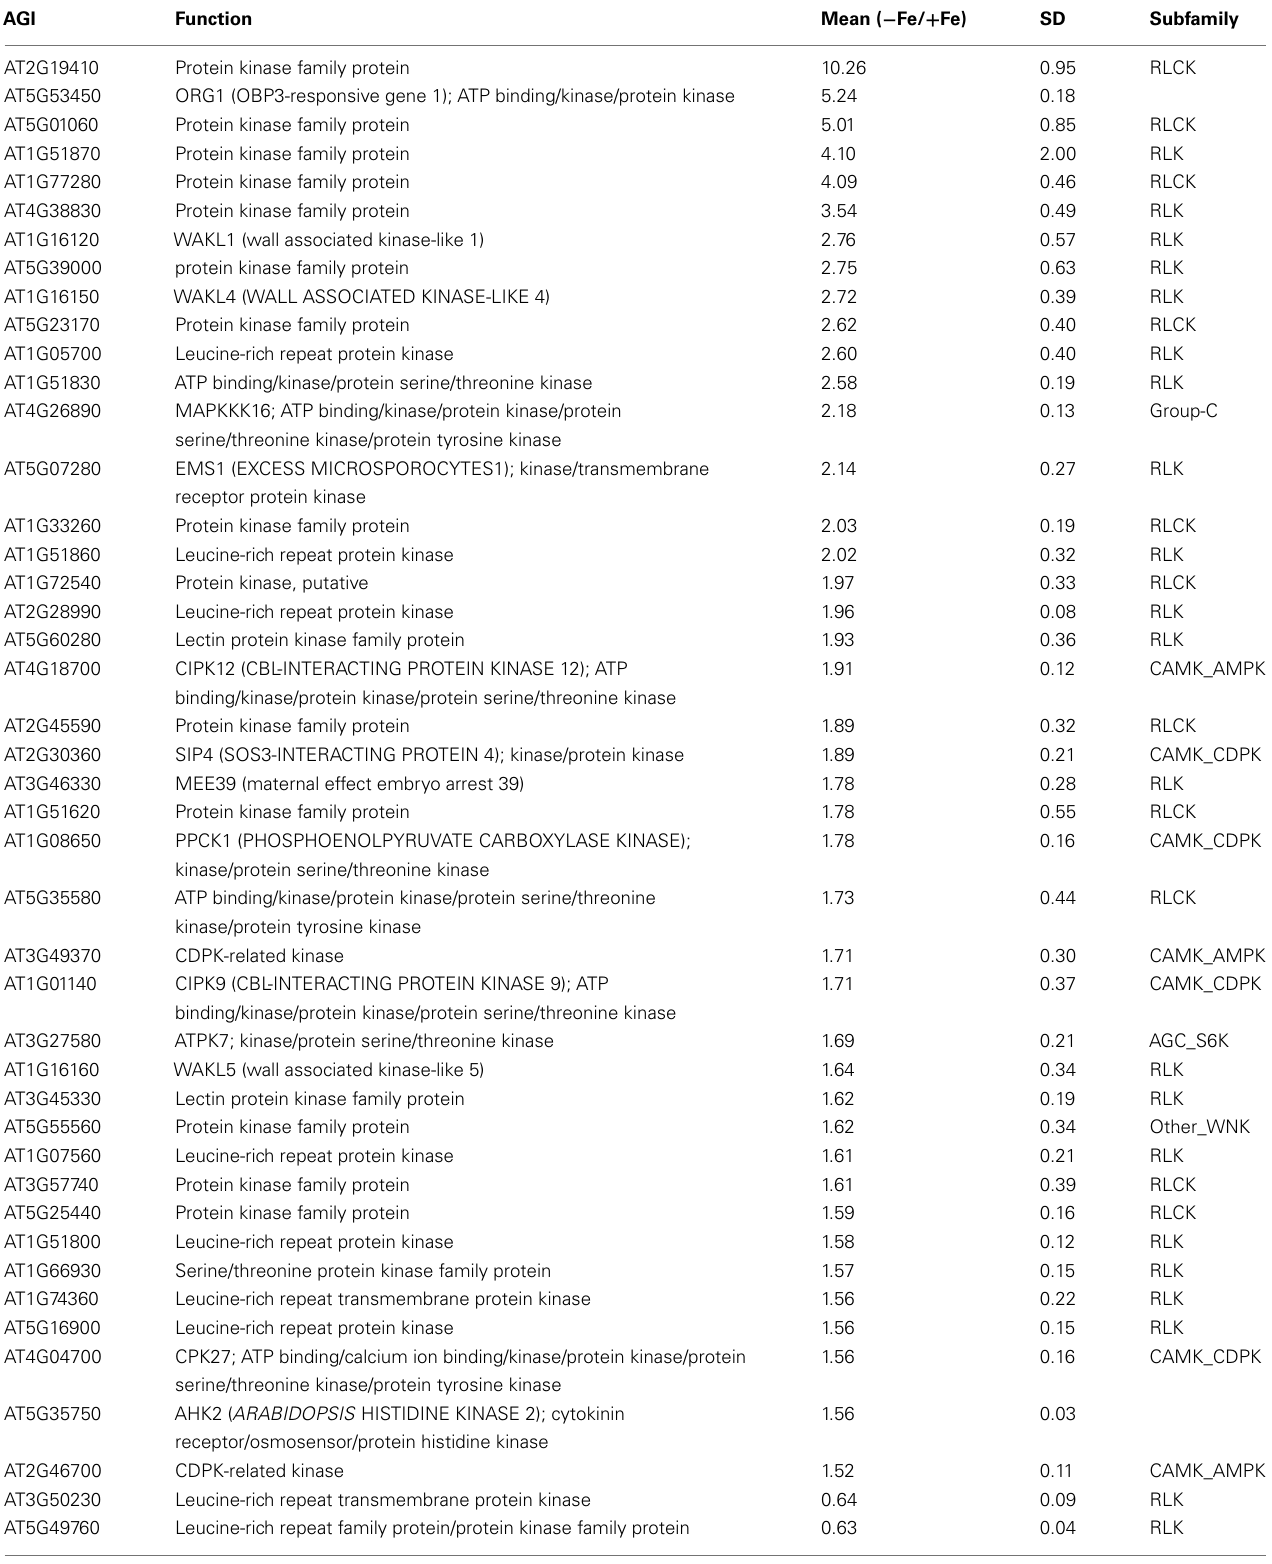
Table 1 | Differentially expressed protein kinase genes upon iron deficiency with fold change of more than 1.5-fold.